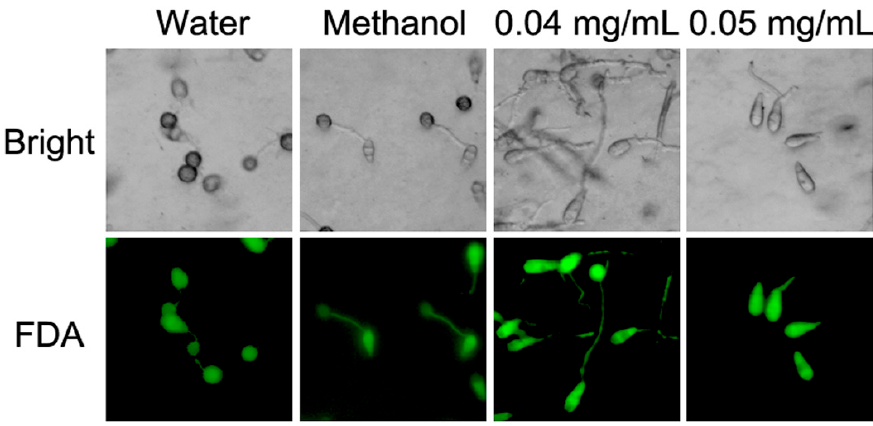
Figure 5. FDA staining to test the viability of conidia treated with equol. Conidia suspensions (1 × 10 5 conidia/mL) supplemented with 0.04 mg/mL and 0.05 mg/mL ( S )-equol were incubated on plastic coverslips at 28 °C in darkness for 24 h to allow for germination and appressorial formation. The suspensions without ( S )-equol and that containing 0.2% methanol were used as controls. After incubation for 24 h, the conidia and appressoria were stained with 100 µ g/mL FDA solution for 5 min and detected under a fluorescent microscope.